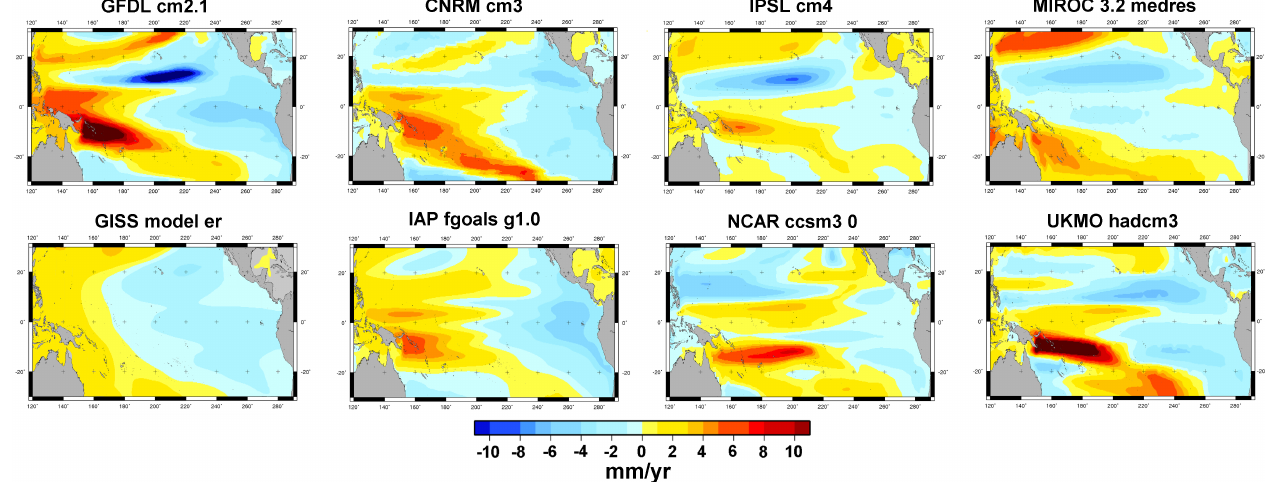
Fig. 5. Spatial patterns of the first rotated EOF of the set of 17-yr trend maps computed with the coupled climate model control runs.